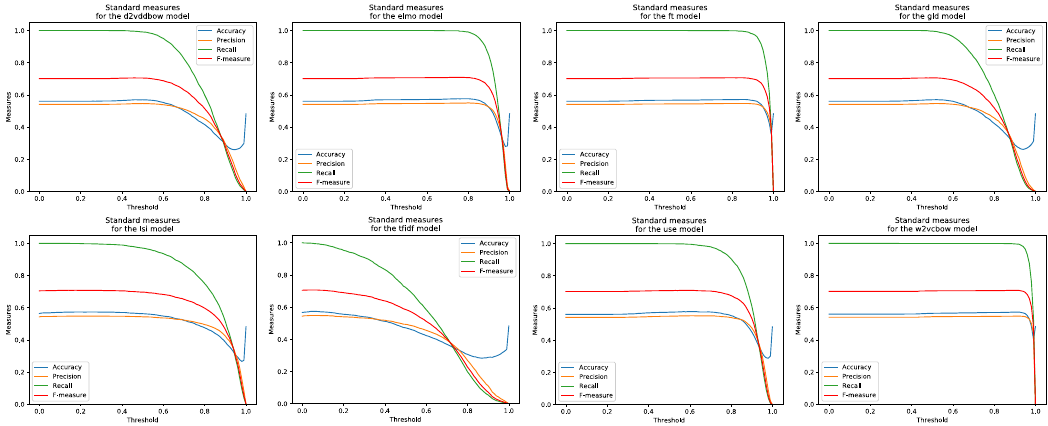
Figure 7. Standard evaluation measures for eight models processing Webis corpus.